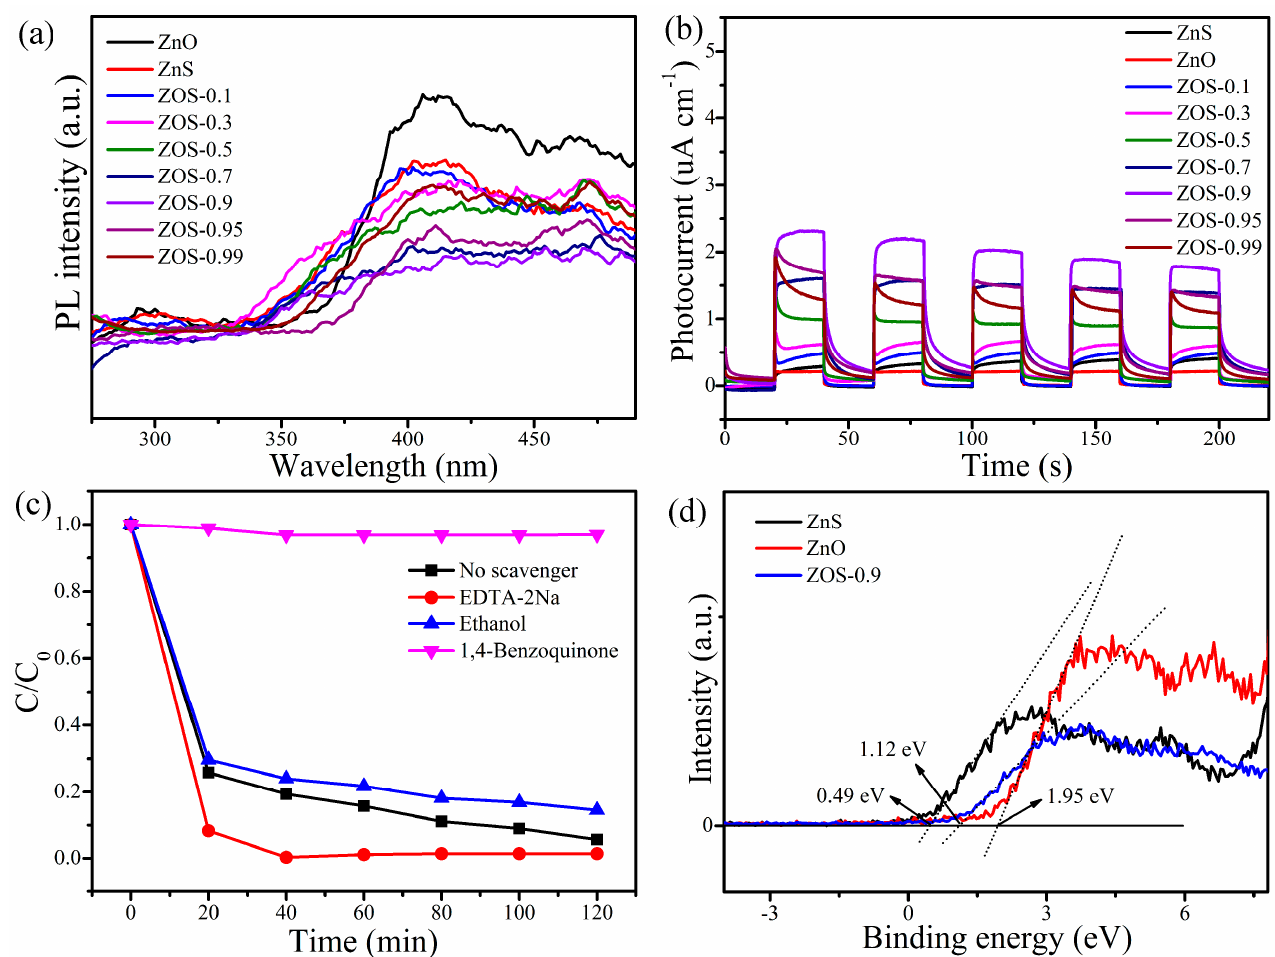
Figure 9. ( a ) Steady-state PL spectra of samples excited at 250 nm; ( b ) transient photocurrent responses of samples; ( c ) free radical capture experiment for degradating MO over ZnO/ZnS photocatalyst ZOS-0.9 under UV light; ( d ) XPS-VB spectra of ZnO, ZnS, and ZOS-0.9.